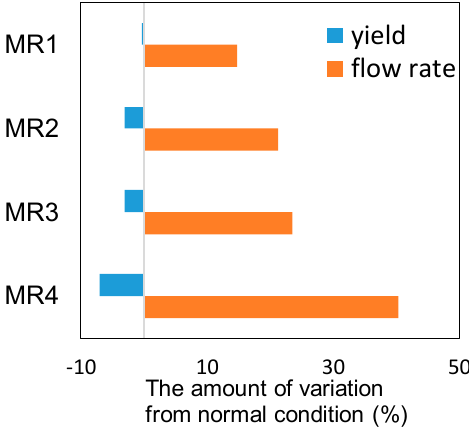
Figure 11. Shift of flow rate and yield under MR5 blockage.